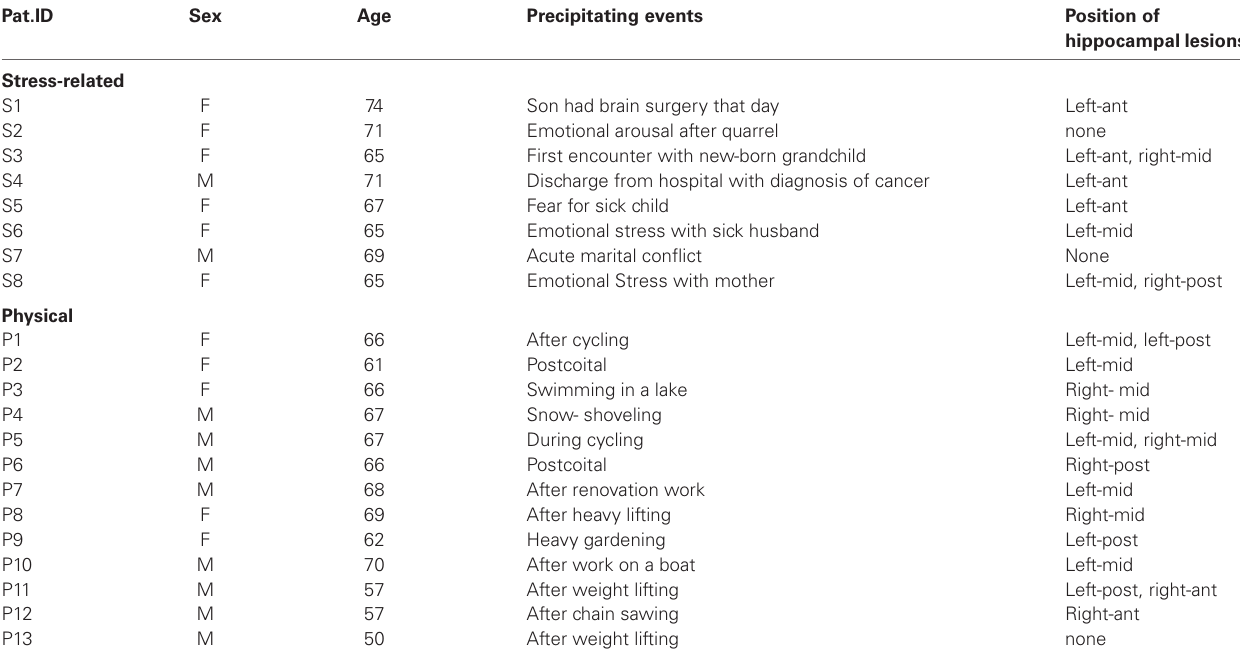
Table 1 | Epidemiological and imaging data of TGA patients with a stress-related and physical precipitant event.